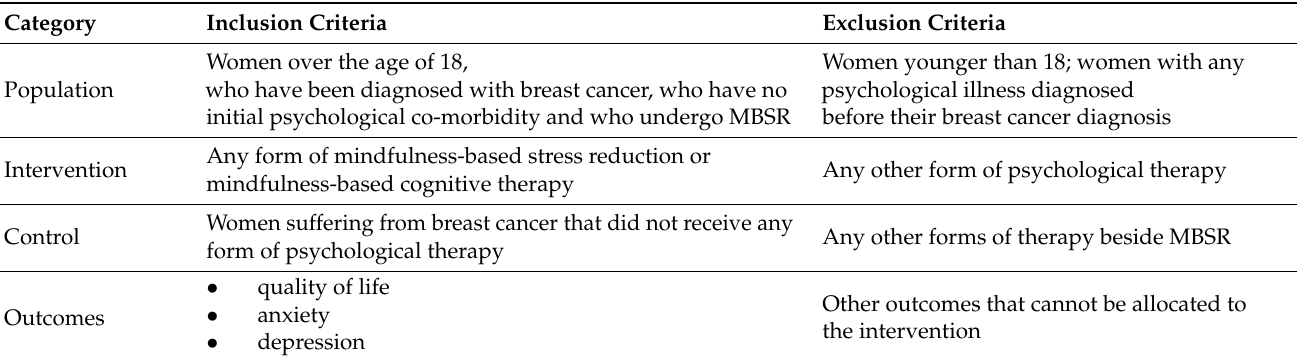
Table 1. Inclusion and Exclusion